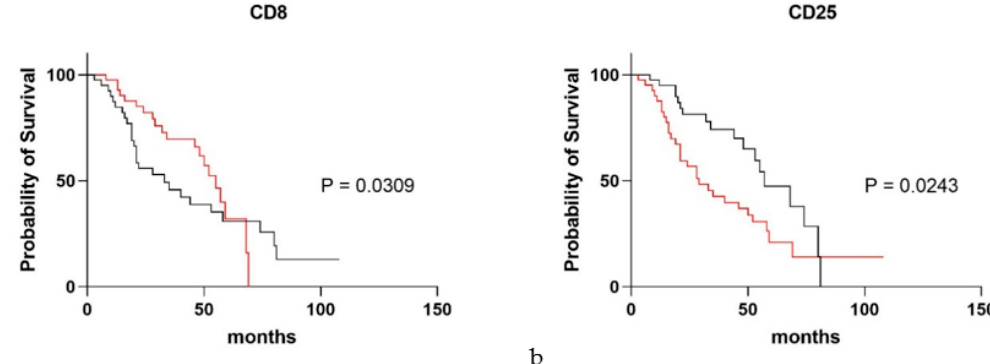
Figure 4. Significant exosomal surface markers in survival analysis of idiopathic pulmonary fibrosis patients. ( a , b ) Kaplan- Maier survival analysis dividing idiopathic pulmonary fibrosis patients according to CD8 (cut-off 1.53) and CD25 (cut-off 0.48), respectively. (red), Thres = FALSE; (black), thres = TRUE.